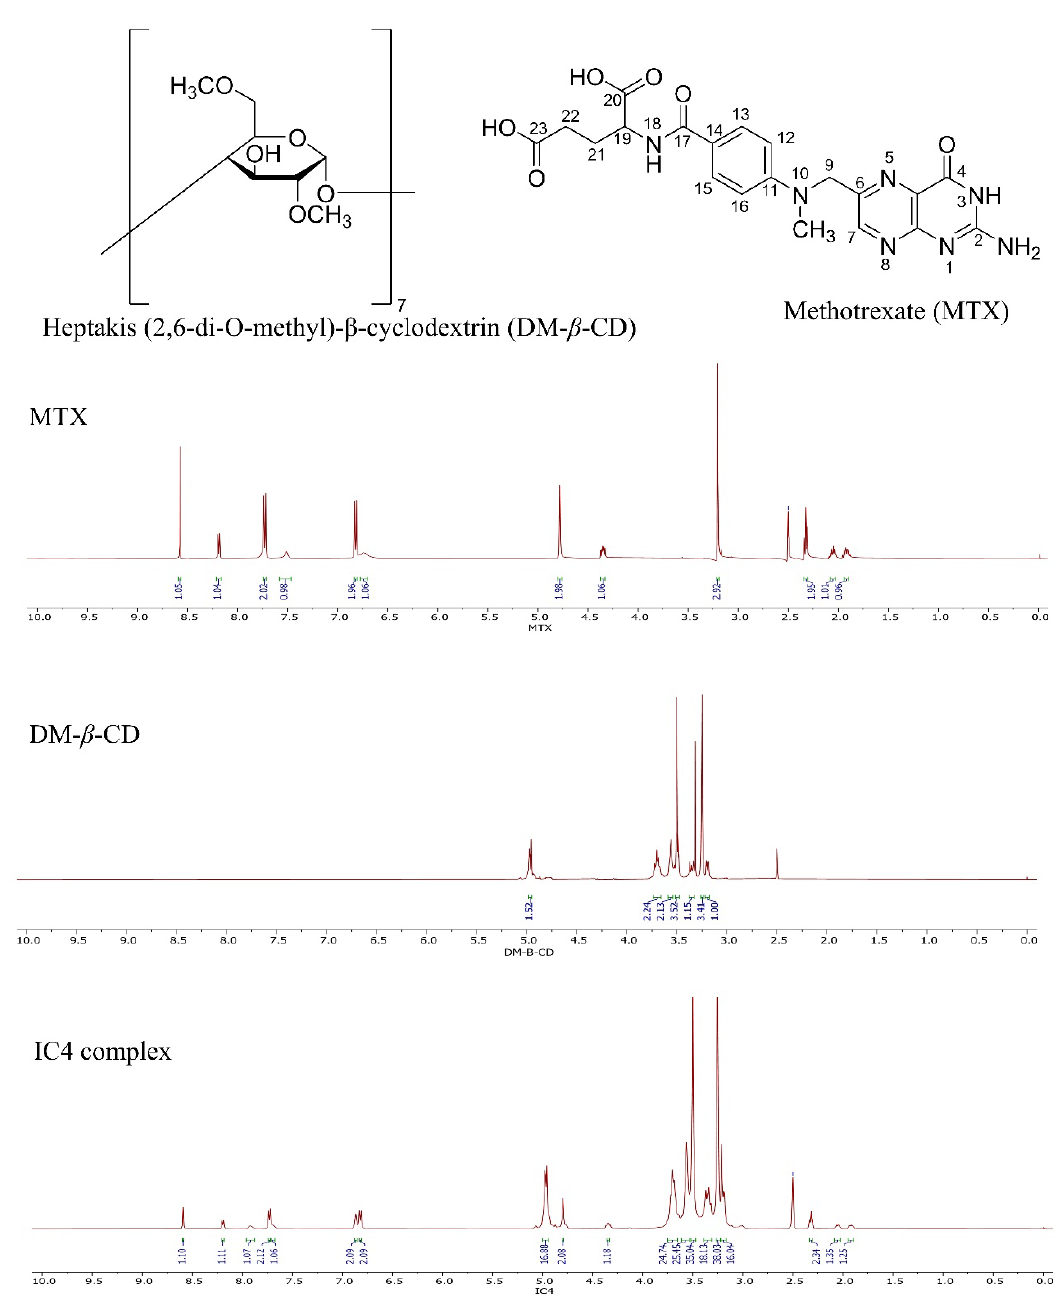
Figure 7. 1 H NMR spectra of MTX; DM- β -CD; and MTX/DM- β -CD (IC4).